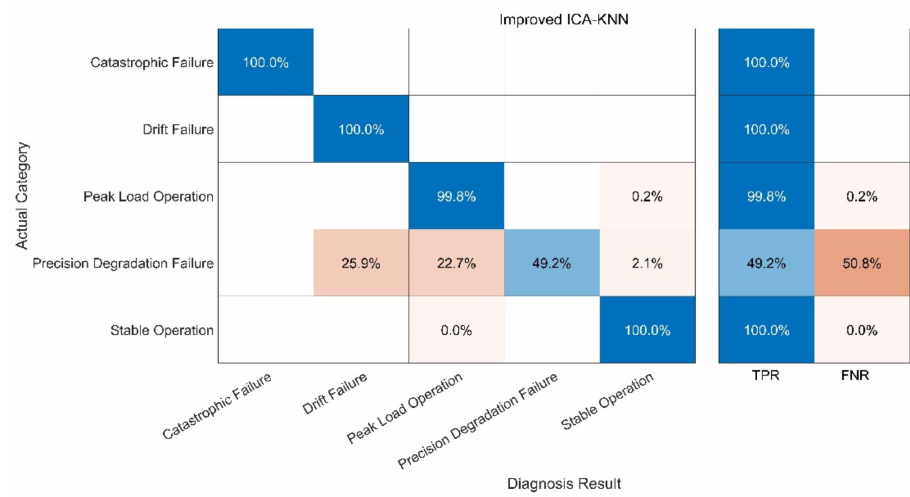
Figure 14. Fault Diagnosis Result of ICA-KNN.